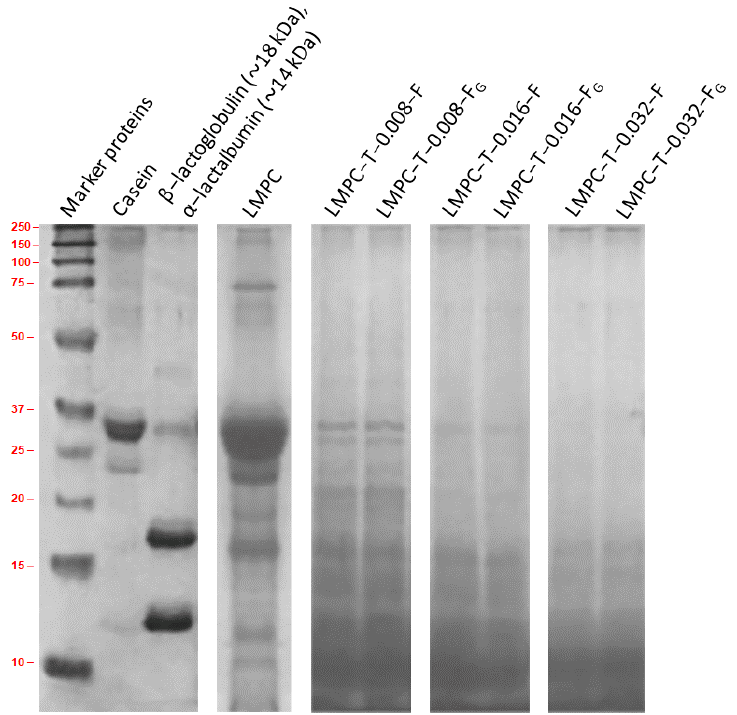
Figure 5. SDS-PAGE image of proteins and peptides in LMPC-F, LMPC-T-F and LMPC-T-F G [33]. LMPC: liquid milk protein concentrate, T: trypsin, F: fermentation with lactic acid bacteria in the absence of glucose, F G : fermentation with lactic acid bacteria in the presence of glucose.